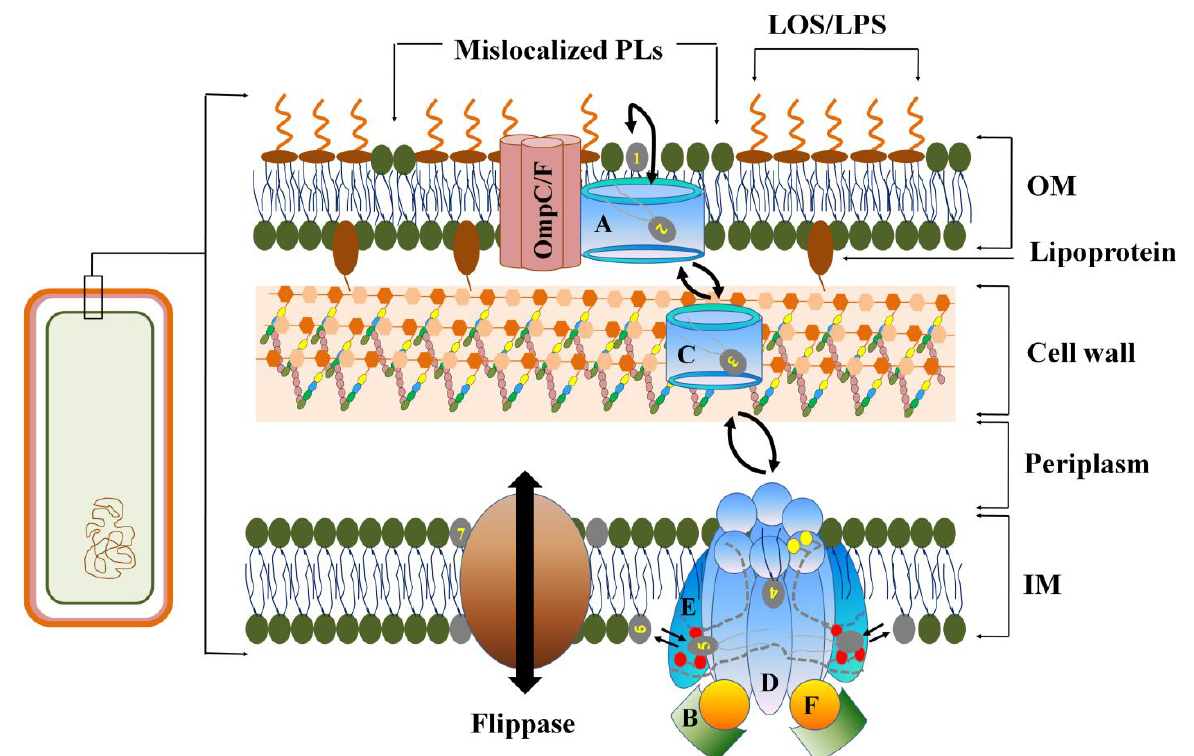
Figure 1. Role of maintenance of lipid asymmetry (Mla) complex in asymmetric distribution of LPS and PLs in the outer (exoplasmic) and inner (periplasmic) leaflets of Gram-negative OM. In Gram-negative bacteria, the inner membrane (IM) is a symmetric bilayer of phospholipids (PLs), whereas the OM is asymmetric with LPS/LOS localized exclusively to the outer leaflet and PLs localized to the inner leaflet. The Mla complex in Acenetobacter baumanii is a six-component protein complex that forms three distinct units: MlaA (A), MlaC (C), and MlaBDEF (B, D, E and F), out of which, MlaA is localized to OM, MlaC is localized to the periplasm, and MlaBDEF complex is localized to the IM. The unique structural features of MlaA enables it to act like a vacuum cleaner to remove any mislocalized PLs from the OM outer leaflet to MlaC that shuttles the mislocalized PLs into the PL binding site of MlaBDEF complex that is oriented toward the periplasm. The route of PLs through IM is formed by the transmembrane domains of MlaD and MlaE as depicted by dotted lines. The selectivity of PLs through the MlaBDEF complex is determined by Leu153/Leu154 (yellow balls) at the periplasmic end and R47, R14, and R234 (red balls) near the cytosolic end. ATP binding sites are present on the MlaF subunits near the MlaE-F interface. The PL pathway through MlaBDEF complex is bilaterally symmetrical, making the PLs use both the routes indiscriminately. From the cytosolic site of the MlaBDEF, the PLs diffuse into the cytosolic leaflet of IM which are equilibrated between both the leaflets facilitated by the biogenic membrane flippases.